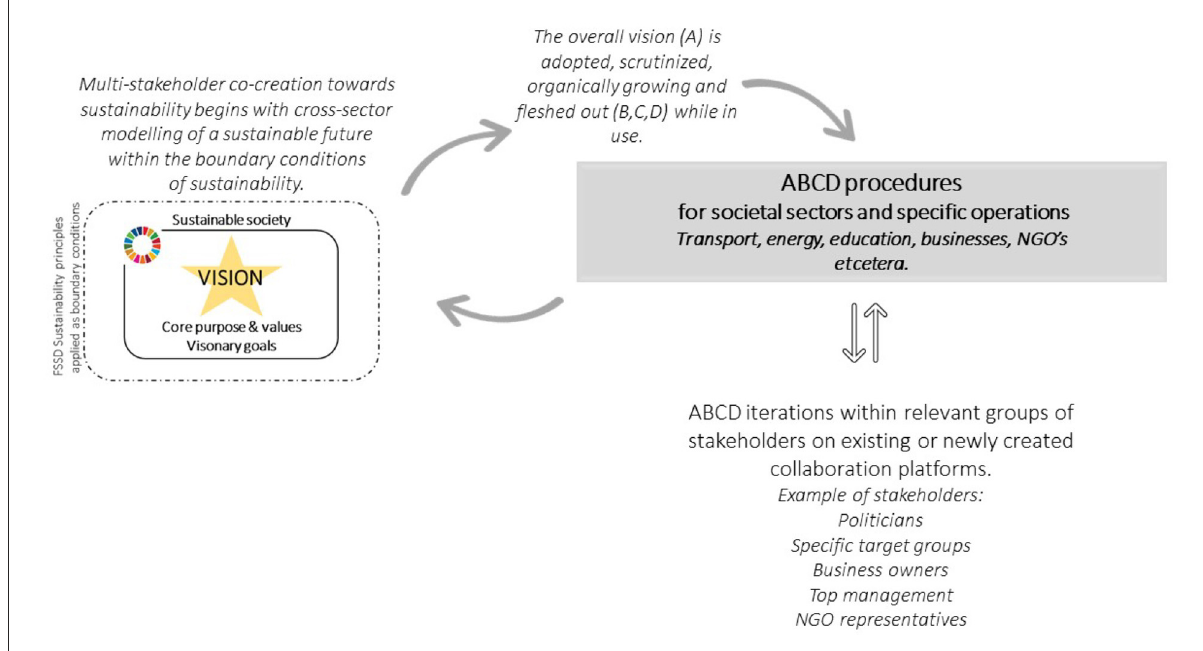
FIGURE1 The FSSD implementation model. Reprinted from (Wälitalo et al., 2020) with